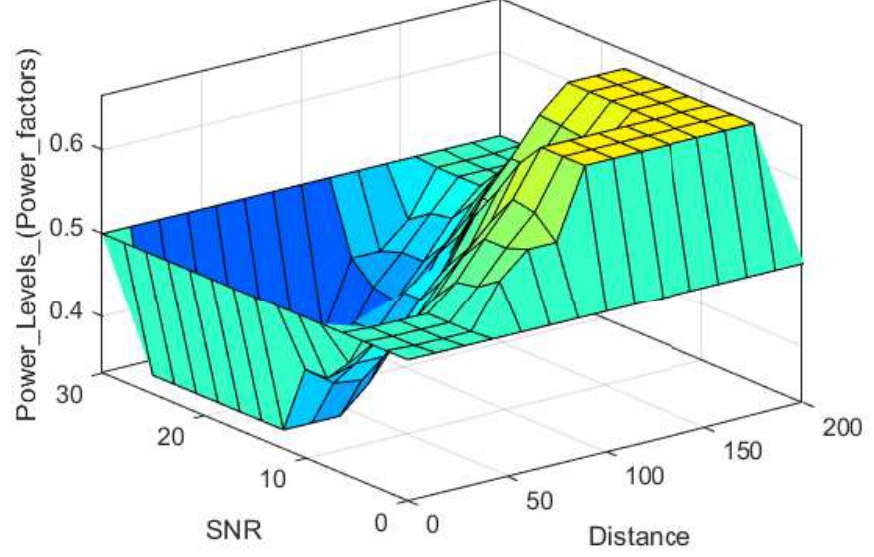
Figure 7. Graphical view of the FIS system’s